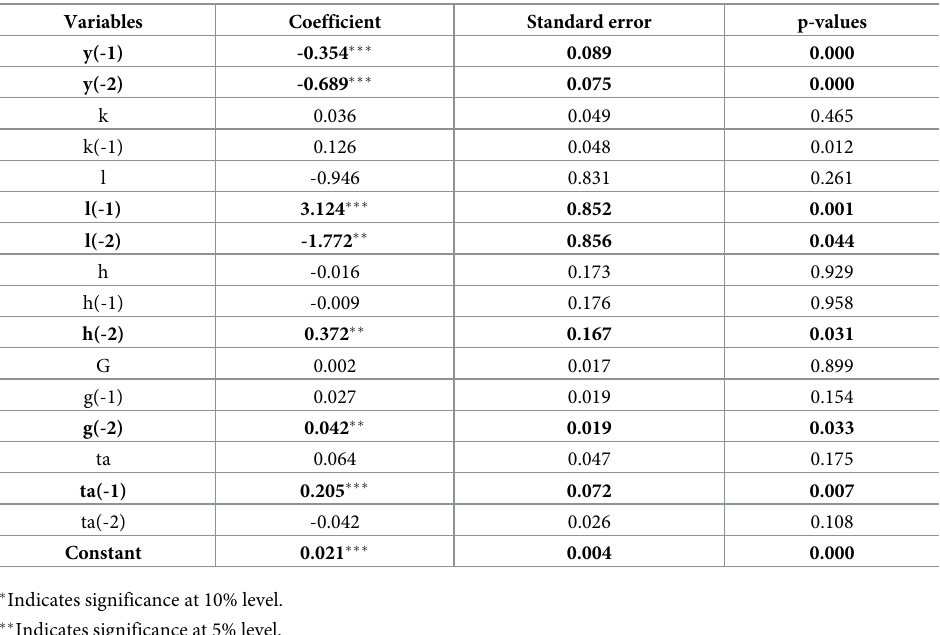
Table 5. Long run ARDL estimate.